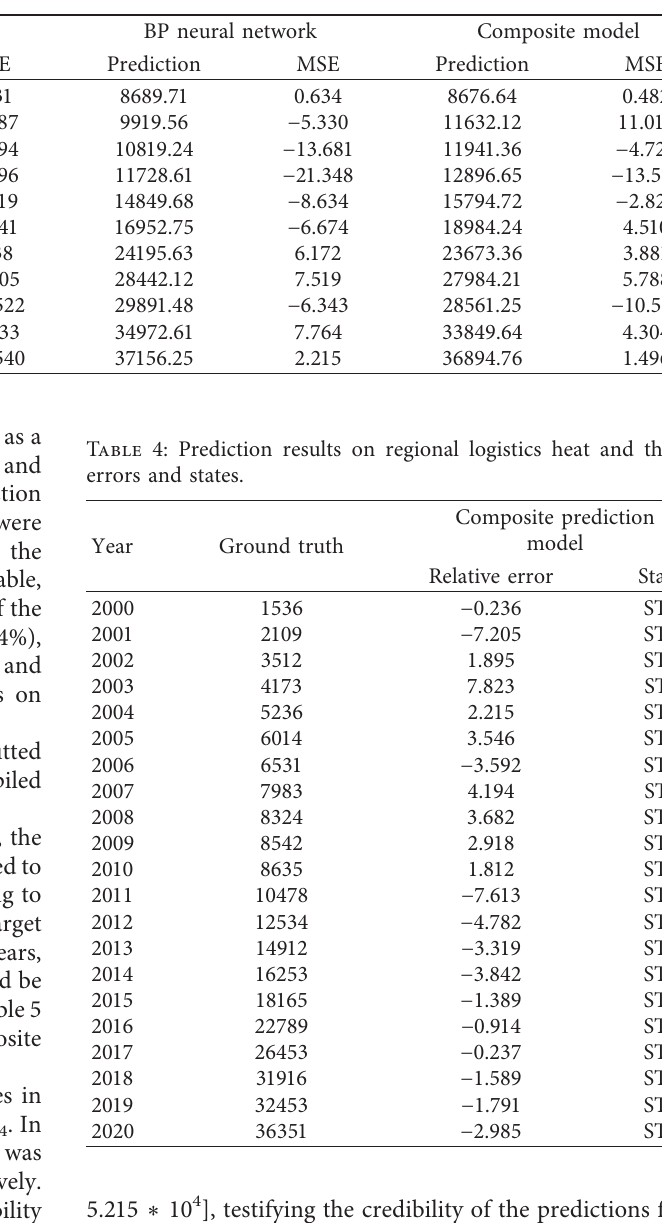
Table 3: Prediction results and errors of different models.